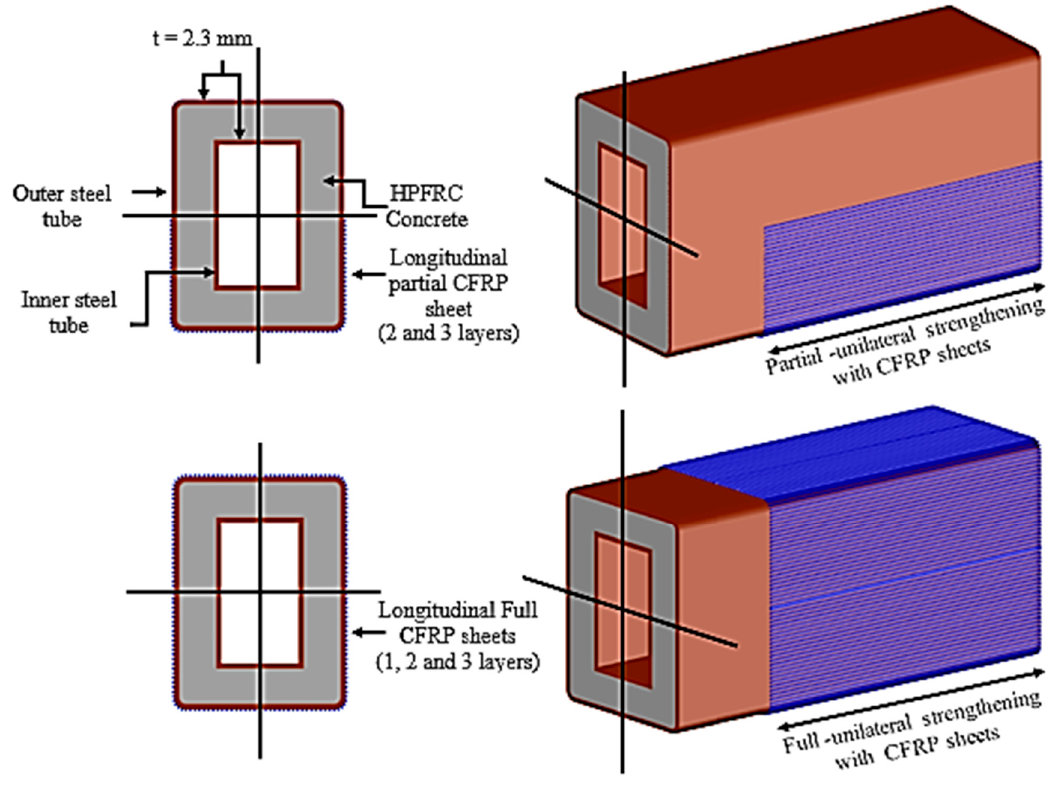
Figure 3. CFRP wrapping sheets: ( a ) partial wrapping scheme for HPCFDST beams, ( b ) full wrapping scheme for HPCFDST beams. Table 4. Labeling of HPCFDST beams strengthening with CFRP sheets.